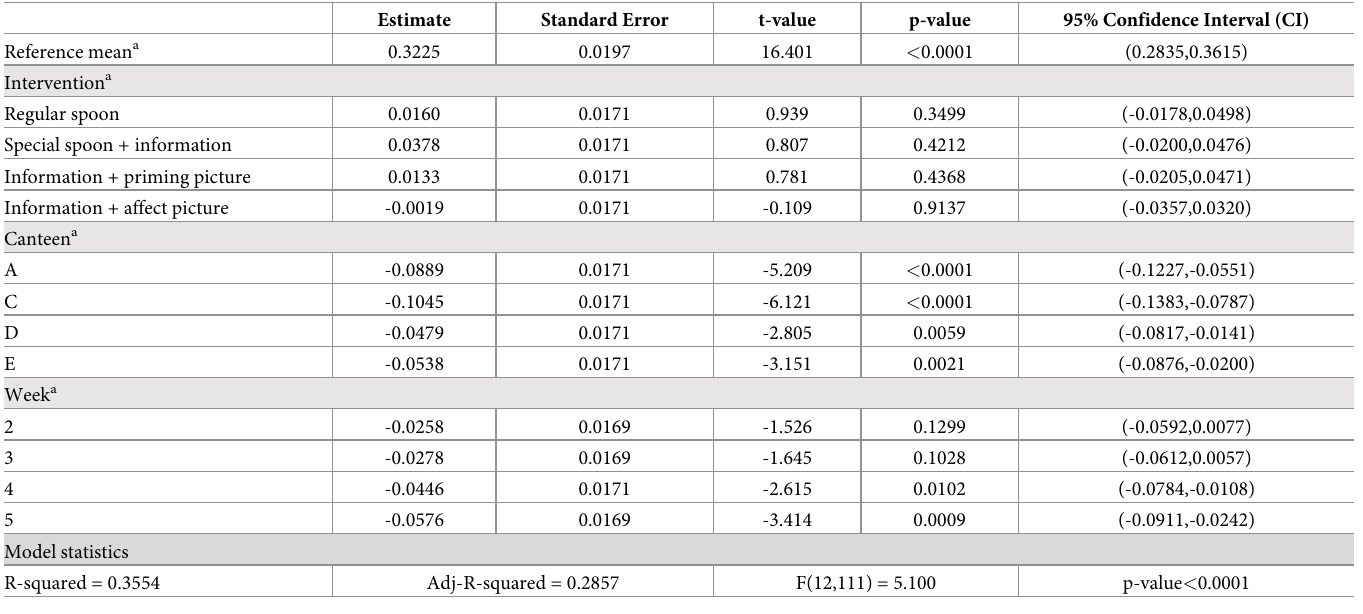
Table 5. Model results for the outcome measurement: % Bowls to which fish sauce was added per bowl sold per